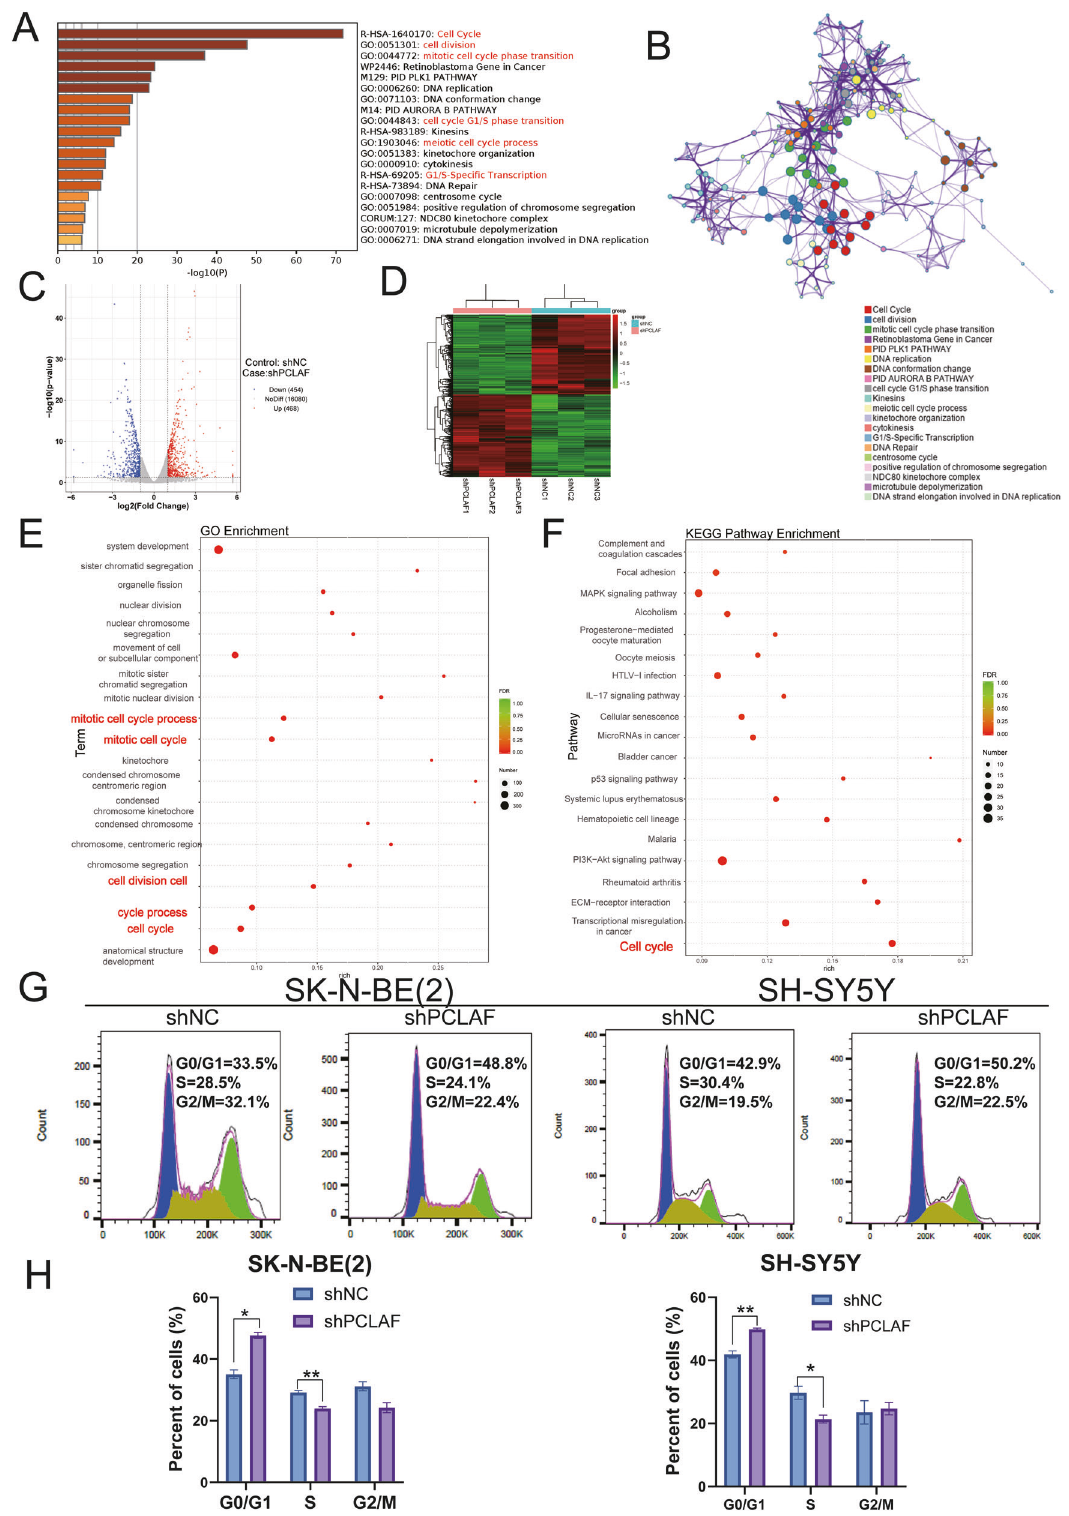
Fig. 3 PCLAF triggers pathways related to cell cycle regulation in RNA-seq data. ( A, B ) Heatmap of Gene Ontology (GO) enriched terms and Kyoto Encyclopedia of Genes and Genomes (KEGG) enriched terms colored by p -values; ( C ) The volcanic map was drawn according to the gene distribution. The abscissa is log2FoldChange, and the ordinate is -log10( p value); ( D ) Cluster heat map of 6 samples. Red represents high expressed genes and green represents low expressed genes; ( E ) The GO enrichment analysis results of differentially expressed genes; ( F ) The KEGG enrichment analysis results of differentially expressed genes. Select the top 20 pathways with the smallest p value for display; ( G, H ) Flow cytometry was used to analyze the cell cycle of neuroblastoma cell lines. (* p < 0.05, ** p < 0.01, *** p < 0.001and **** p < 0.0001, and bar graphs represent the mean ±